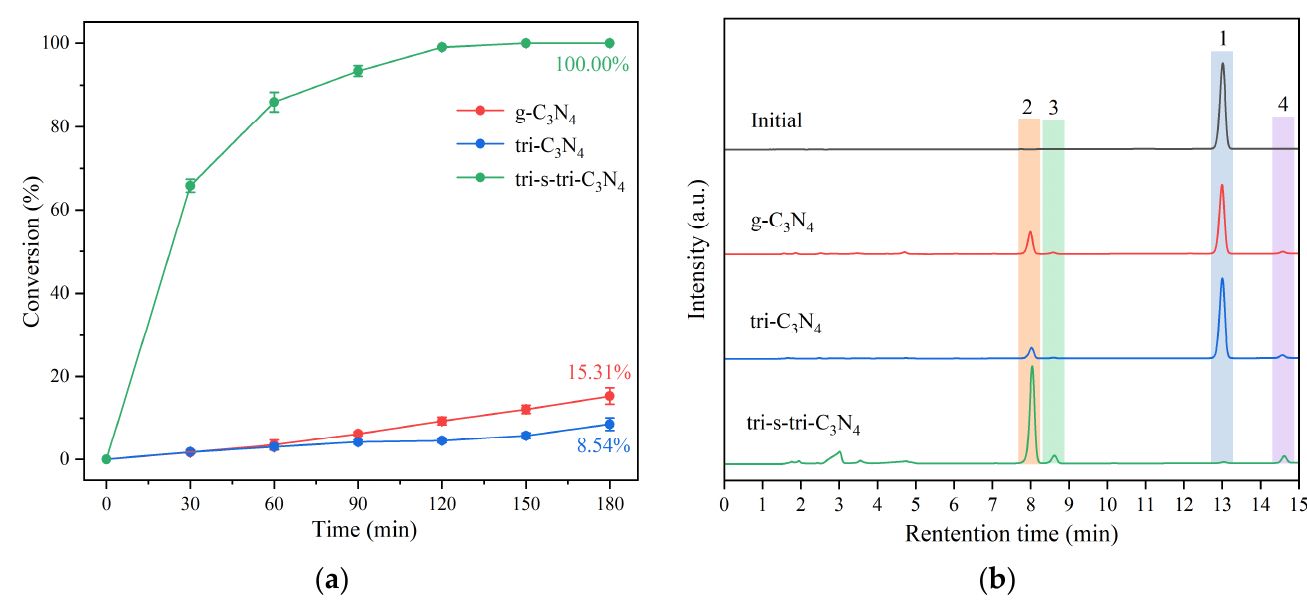
Figure 9. Conversion plot ( a ) and HPLC ( b ) of ML conversion using different carbon nitride photocatalysts at 3 h. Table 1. The results of the photocatalytic conversion of ML under different reaction